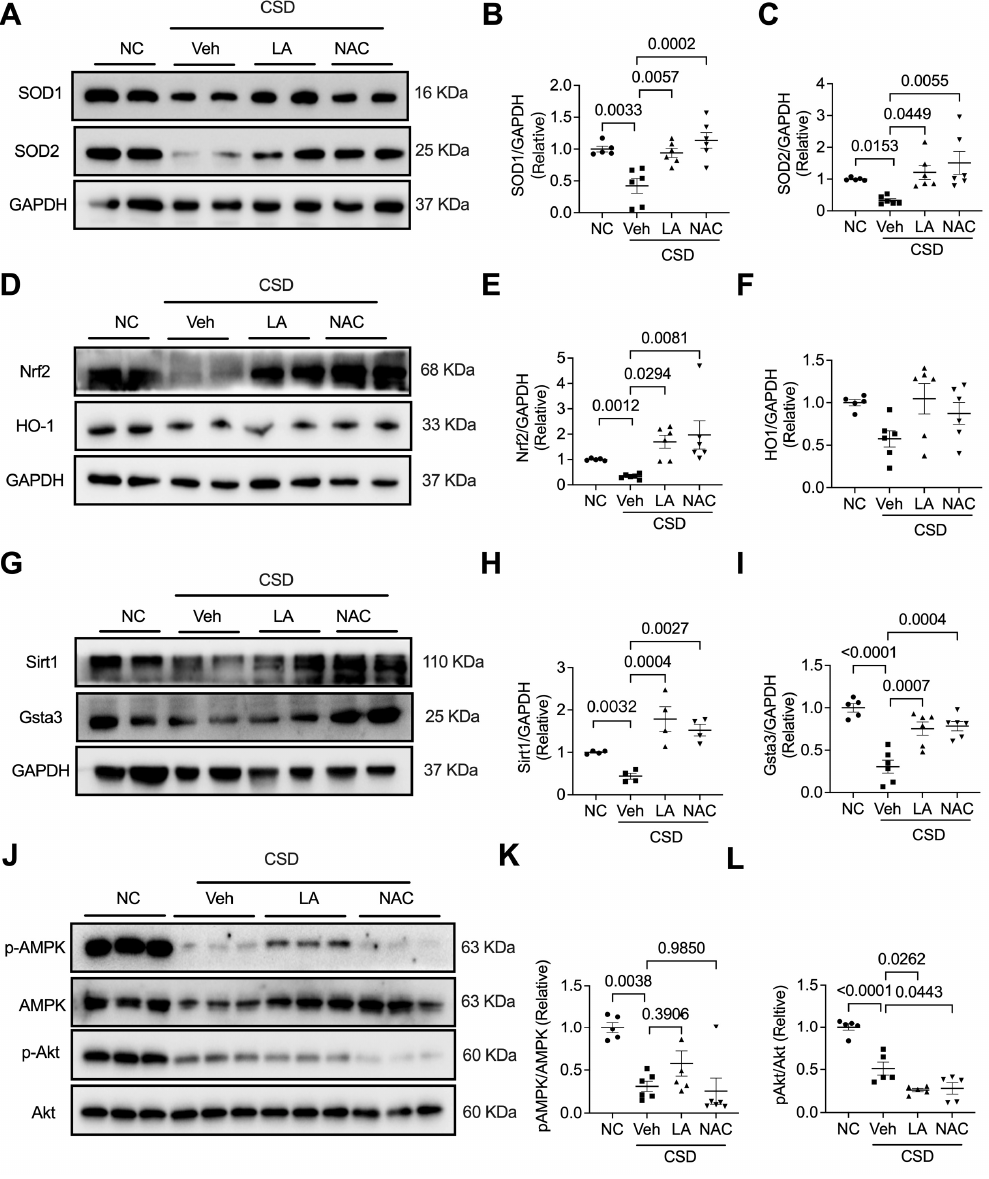
Figure 6. Antioxidants regulated Sirt1/Gsta3/SODs signaling pathway in CSD-induced heart failure. Representative western blot images and quantification of SOD1 ( A , B ), SOD2 ( A , C ), Nrf2 ( D , E ), HO1 ( D , F ), Sirt1 ( G , H ), Gsta3 ( G , I ), and the phosphorylation of AMPK ( J , K ) and Akt ( J , L ) in four indicating hearts.